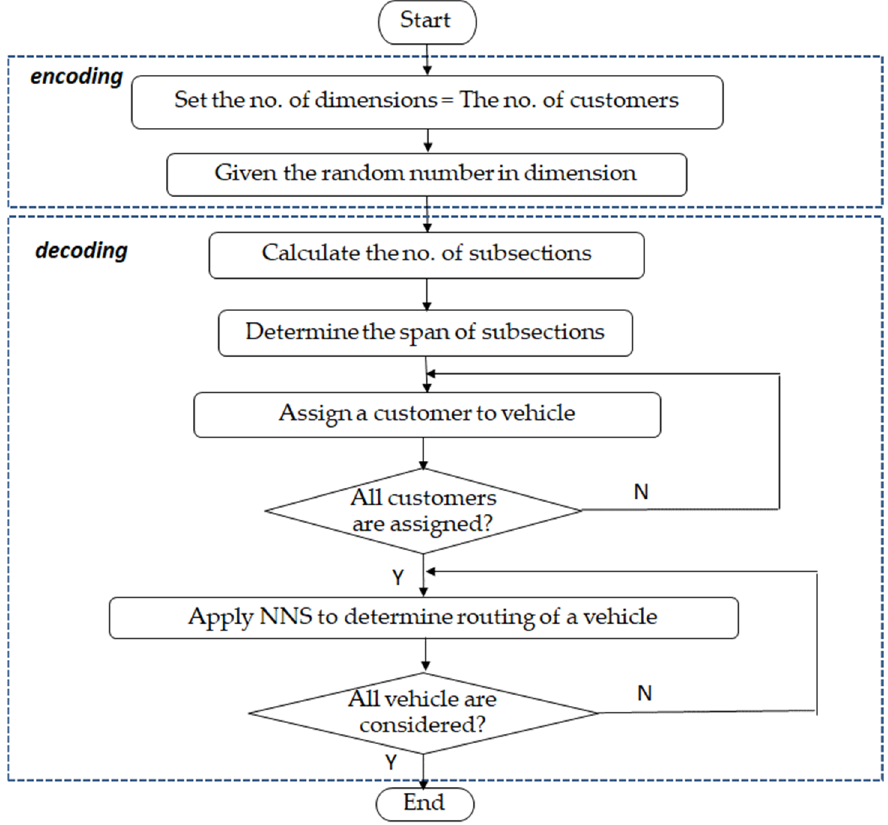
Figure 3. Solution representation procedures.